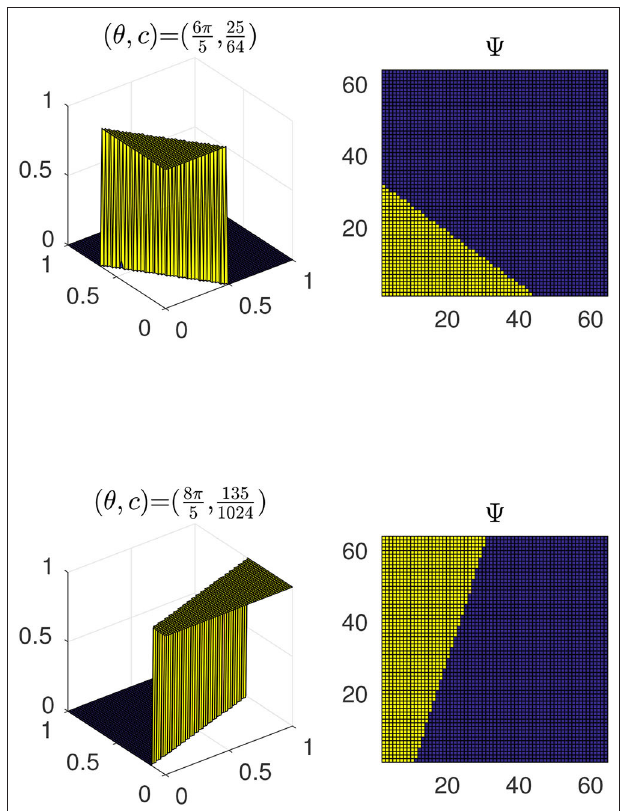
FIGURE 1 | Illustrating the surfaces corresponding to the approximated Heaviside functions for varying pairs of θ and c .